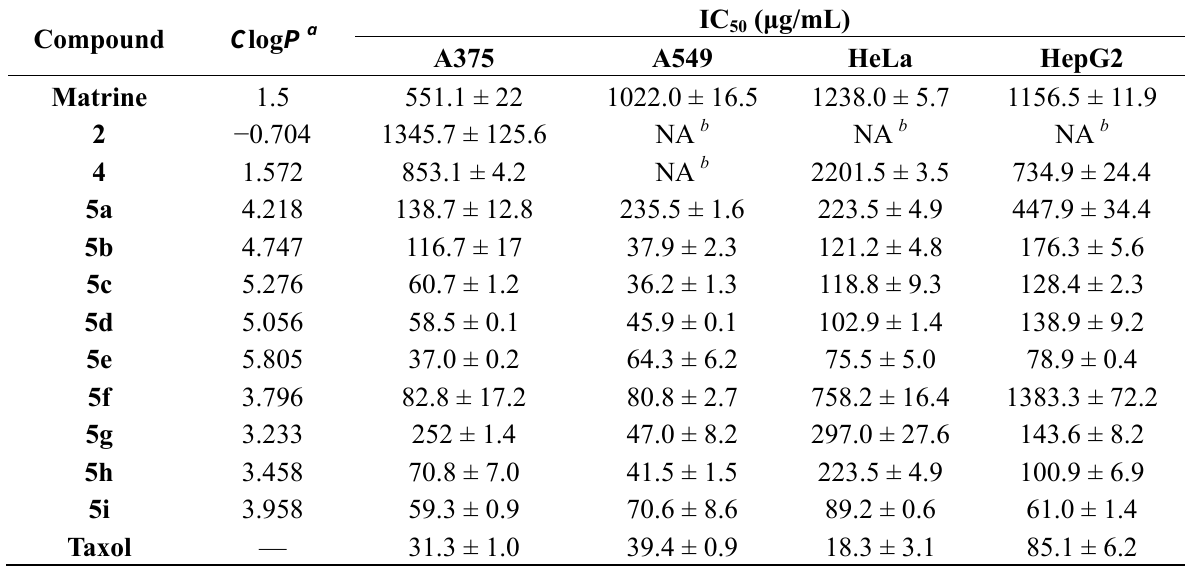
Table 1. Lipophilicity and IC of matrine, taxol, and synthesized matrinic acid derivatives 50 against A375, A549, HeLa, and HepG2